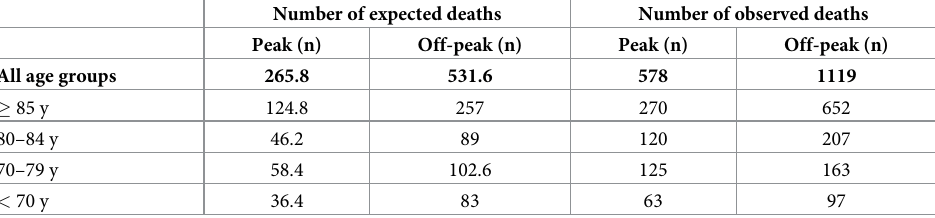
Table 2. Number of expected and observed deaths during both peak and off-peak phases of the COVID-19 epi- demic in